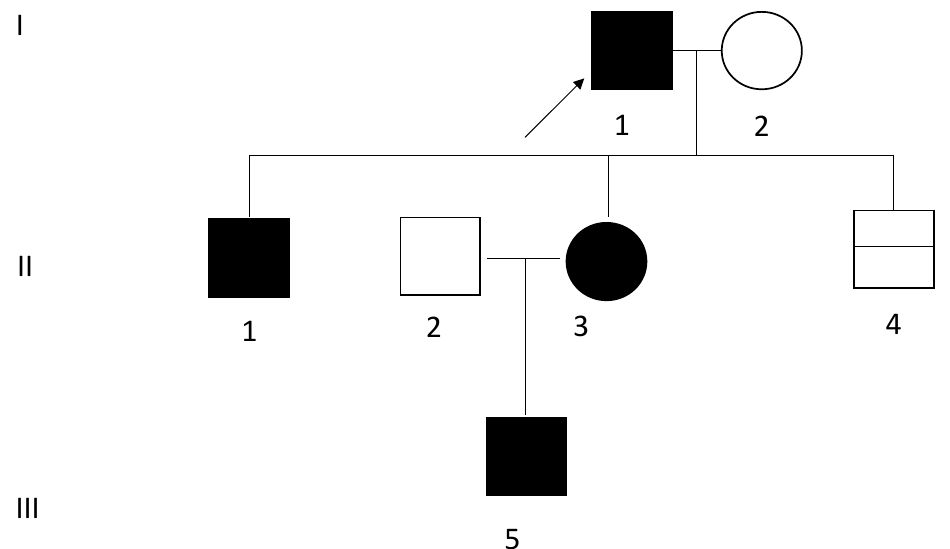
Figure 1. Pedigree of a family with Familial Hyperinsulinemic Hypoglycemia; (FHH) with Glucokinase ( GCK ) mutation. Generations available for the study are indicated by Roman numerals I–III. Black symbols indicate an affected subject. Squares represent male; circles represent female. The arrow indicates the index patient. The horizontal line in square II.4 indicates a negative GCK variant gene test.